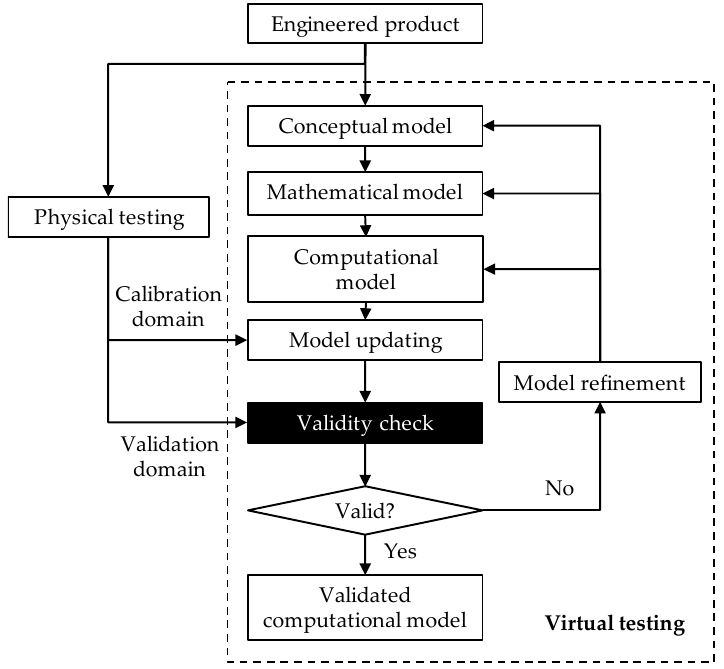
Figure 1. Validation activities for computational models in mechanics [8] .